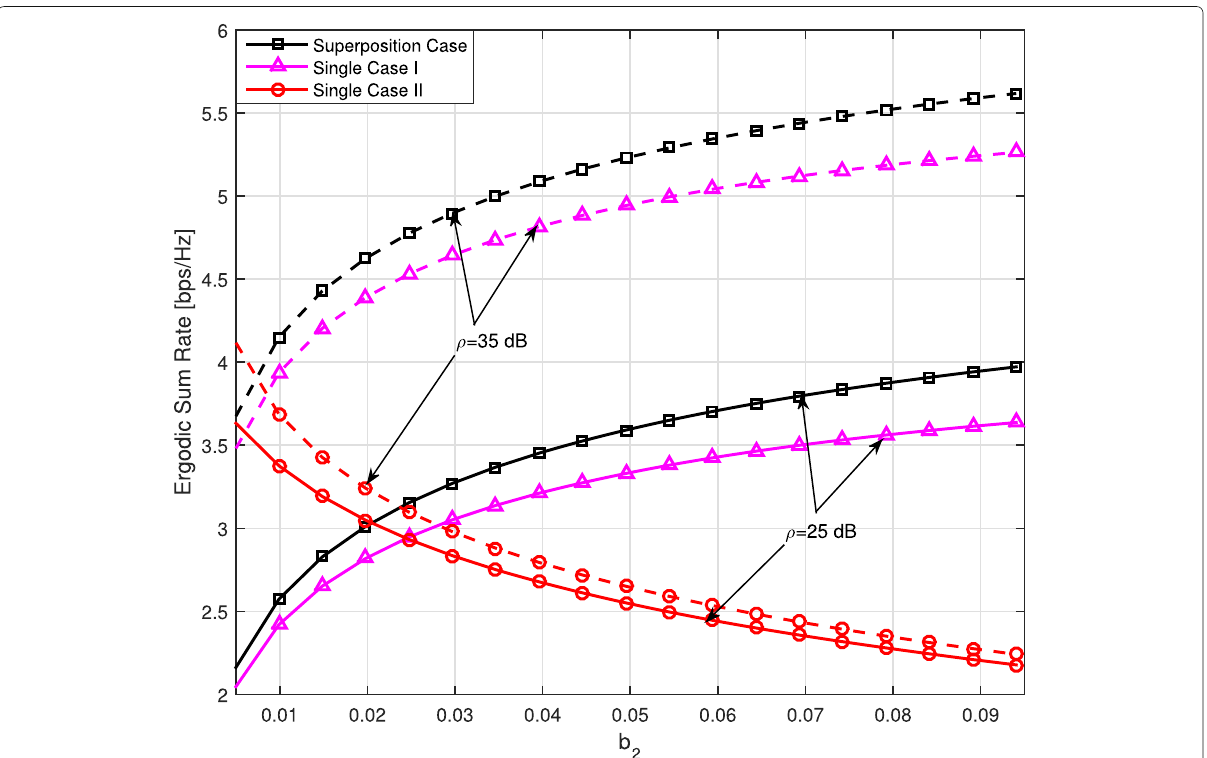
Fig. 6 The ergodic SRs achieved by our proposed CTRS-NOMA single case I, CTRS-NOMA single case II, and CTRS-NOMA superposition case versus power allocation factors b 2 for different transmit SNRs as ρ = { 25,35 } dB